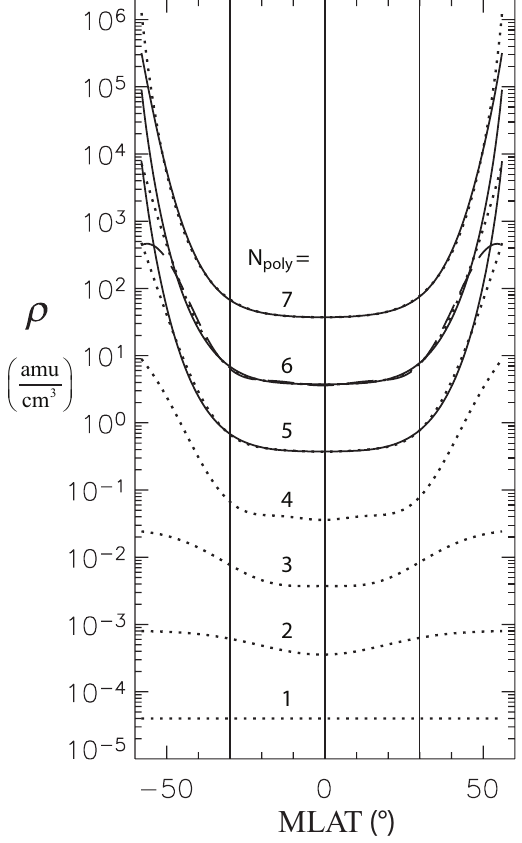
Fig. 16. Solutions for mass density based on the peak frequencies f n − input from Table 2. The numerical labels indicate the number of polynomials N poly used in Eq. (1). The values of ρ for N poly < 7 are divided by 10 7 − N poly so that they do not overlap. The solid (dotted) curves show the solutions using N freq = 8 ( N freq = N poly ) frequen- cies. The dashed curve is a second solution for N freq = N poly = 6 as described in the